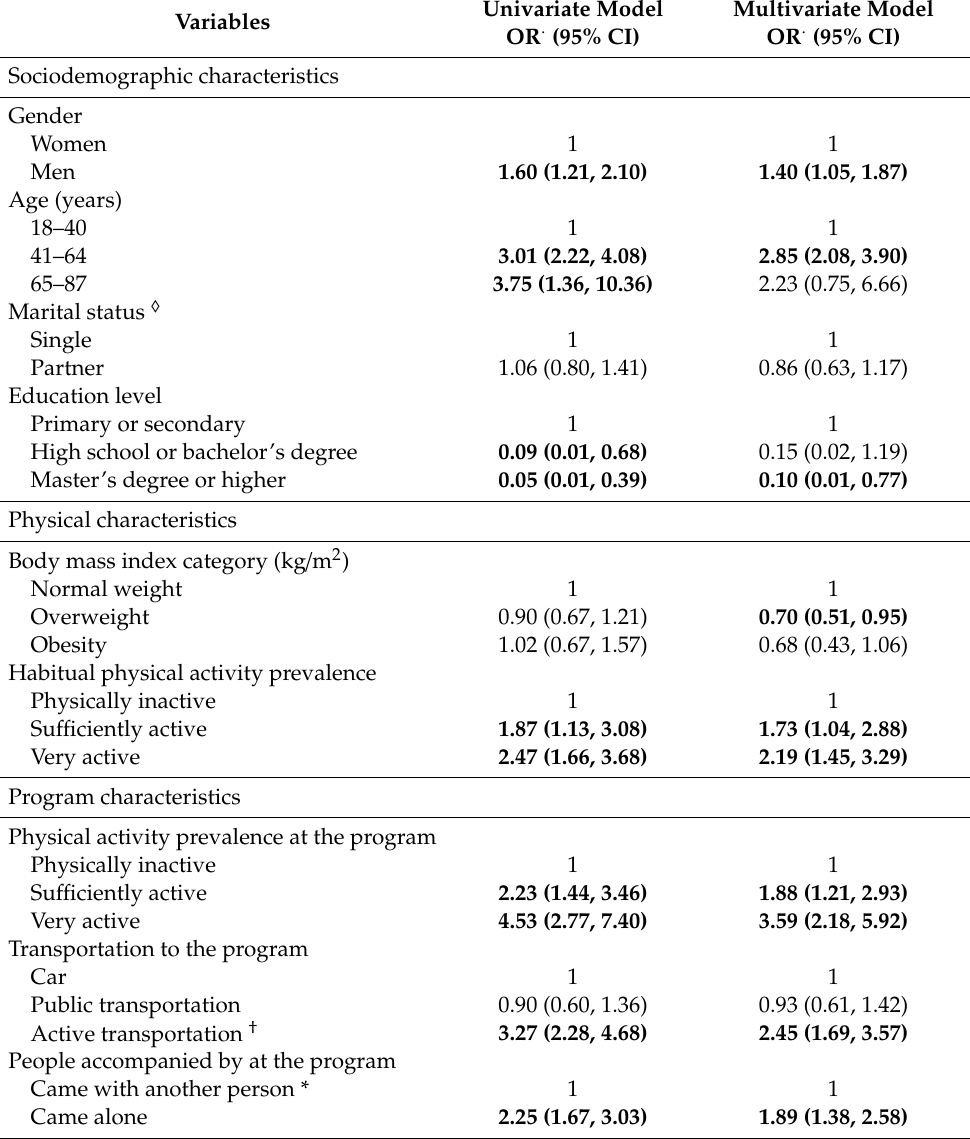
Table 3. Ordinal regression analysis for the association between the frequency of attendance and sociodemographic, physical, and program